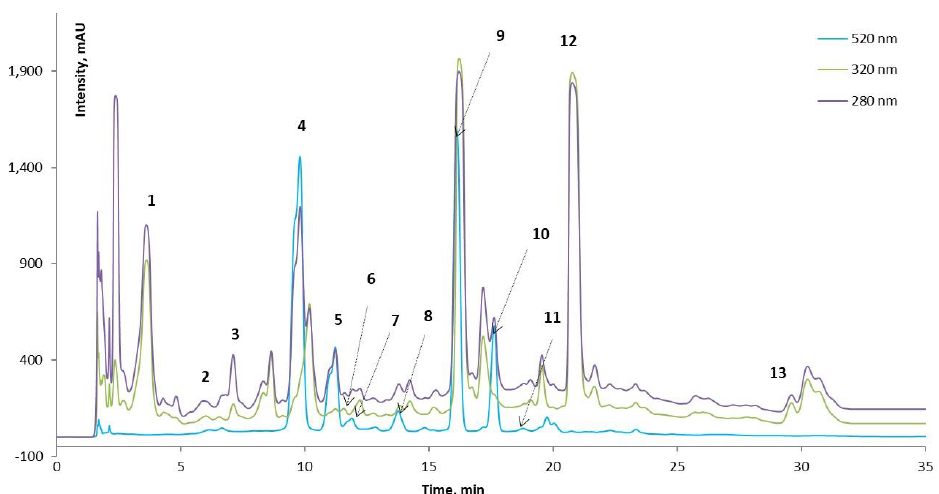
Figure 2. HPLC chromatograms of phenolic and polyphenolic compounds quantified in the ex- tracts of red OS: peak 1-catechin, peak 2-chlorogenic acid, peak 3-vanillic acid, peak 4-cyanidin 3-laminaribioside, peak 5-cyanidin 3-(3”-malonylglucoside), peak 6-ferulic acid, peak 7-peonidin 3- glucoside, peak 8-cyanidin 3-(6”-malonylglucoside), peak 9-cyanidin 3-(6”-malonyl-laminaribioside), peak 10-peonidin 3-malonylglucoside, peak 11-cyanidin 3-dimalonylaminaribioside, peak 12- quercetin, and peak